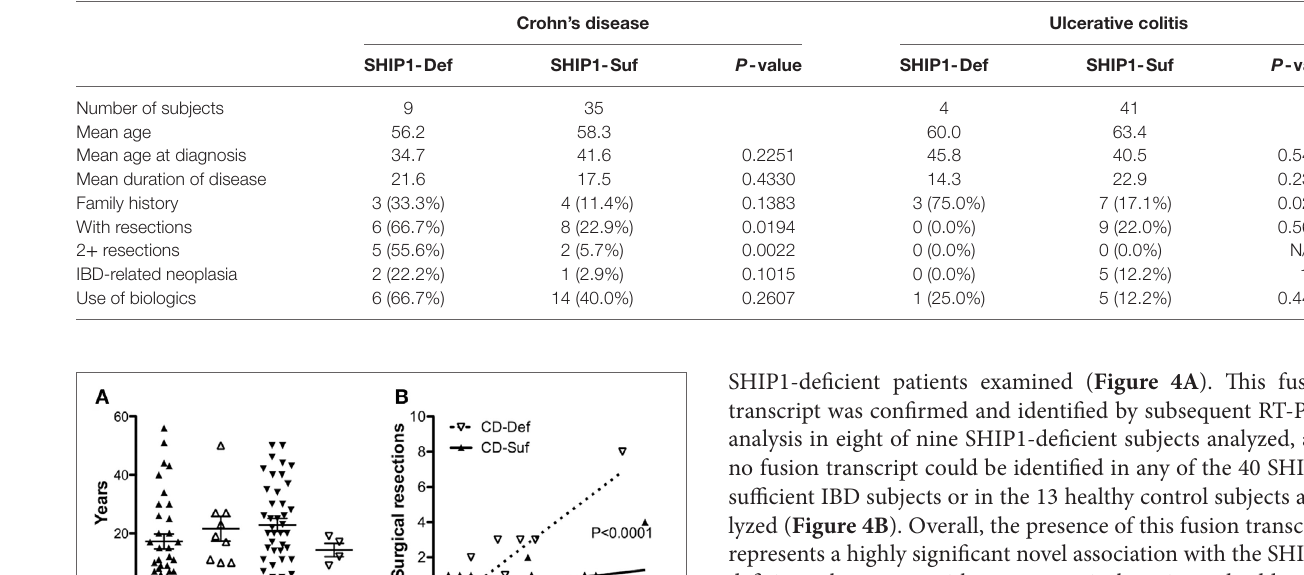
TaBle 1 | Clinical characteristics of the IBD subjects in the